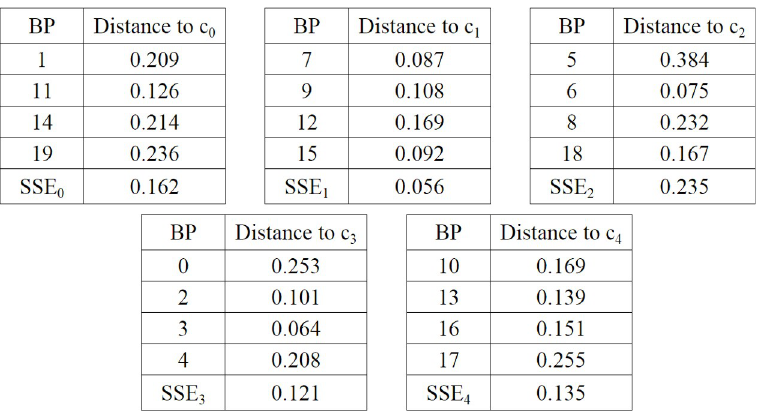
Fig 9. SSE values for each cluster.